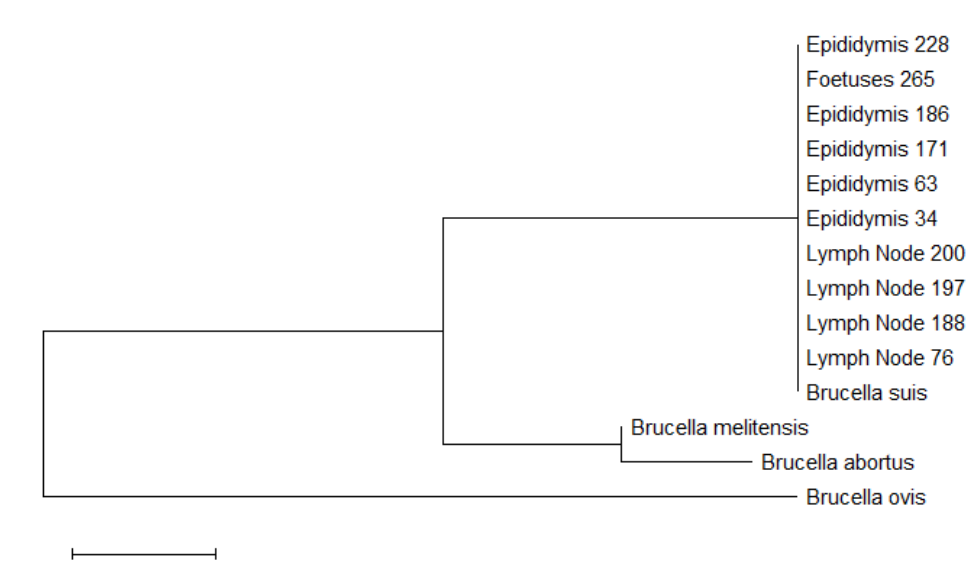
Figure 2. Molecular phylogenetic analysis for 16s rRNA gene of positive lymph nodes and epi- didymides with Brucella suis , Brucella melitensis , Brucella abortus , and Brucella ovis by the maximum likelihood method based on the Tamura–Nei model. The branch lengths of the tree measured the number of substitutions per site. The analysis involved 14 nucleotide sequences. There was a total of 534 positions in the final dataset.